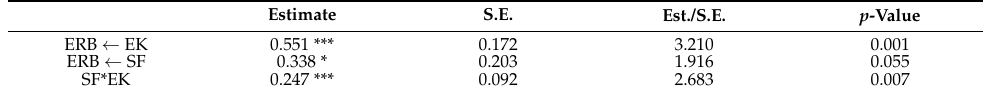
Table 6. Unstandardized path coefficients and significance of model.